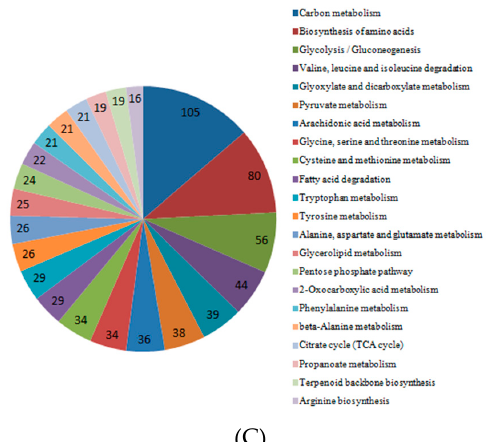
Figure 7. Significant pathways and numbers based on KEGG analysis of DEGs in cotton roots, stems, and leaves. ( A ) Significant pathways and numbers of DEGs in roots; ( B ) significant pathways and numbers of DEGs in stems; ( C ) significant pathways and numbers of DEGs in leaves.